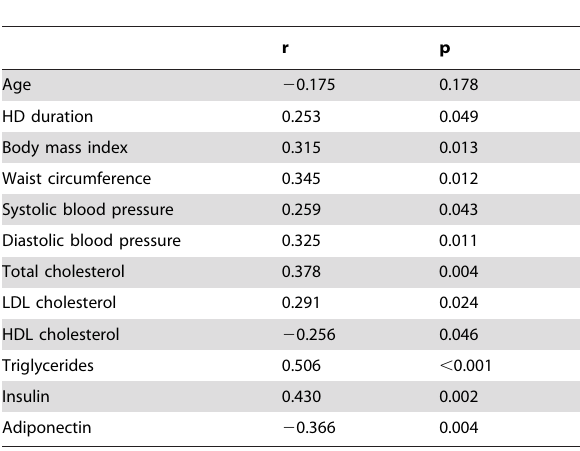
Table 1. Simple regression analysis for log FABP4.